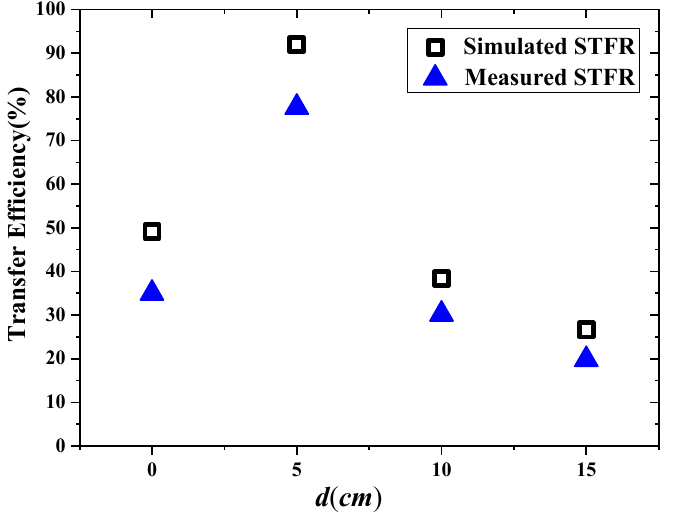
Figure 13. Comparison of the total efficiency of the simulation and measurement results of the STFR WPT system integrating with metasurface, respectively.